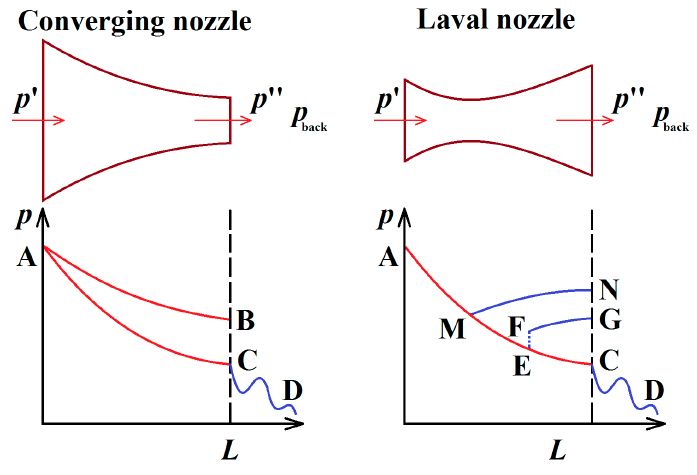
Figure 5. Expansion process in nozzle.